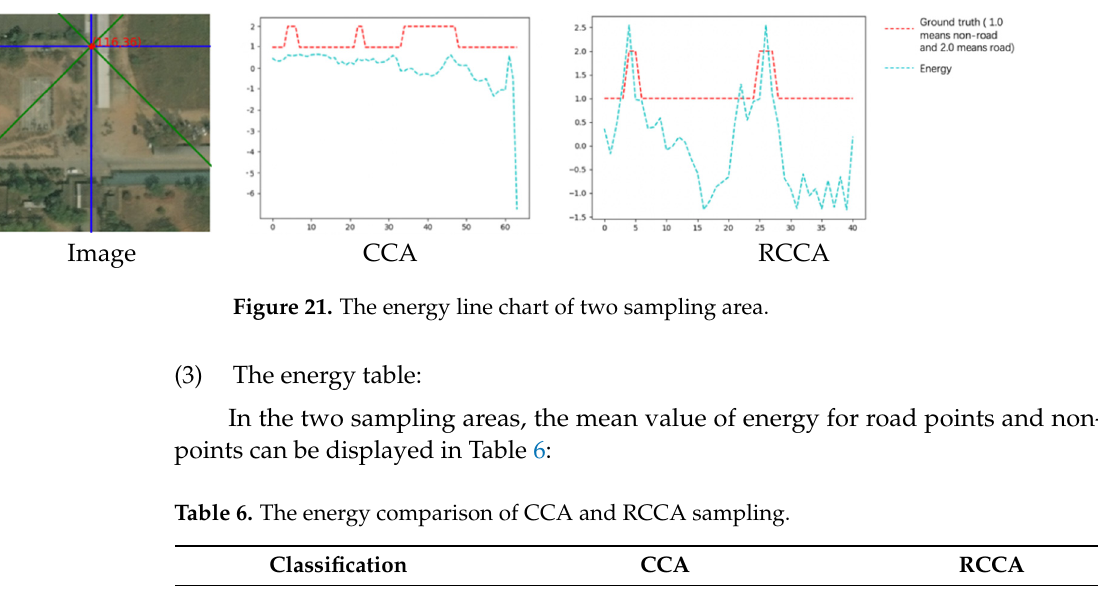
DCCA Figure 22. Image, ground truth and the output compilation. 4.3.2. Example with Only Rotated Crisscross Shaped Roads The next example is for the road in a rotated crisscross shape: Figure 23 shows an image with a rotated crisscross-shaped road and its correspond- ing ground truth. The selected red points on the image are used to analyse the energy.